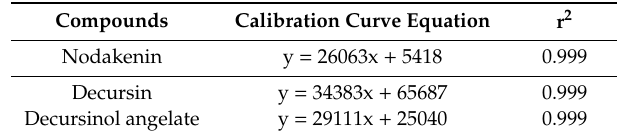
Table 11. Calibration curve equations of Nodakenin, Decursin, and Decursinol angelate. Compounds